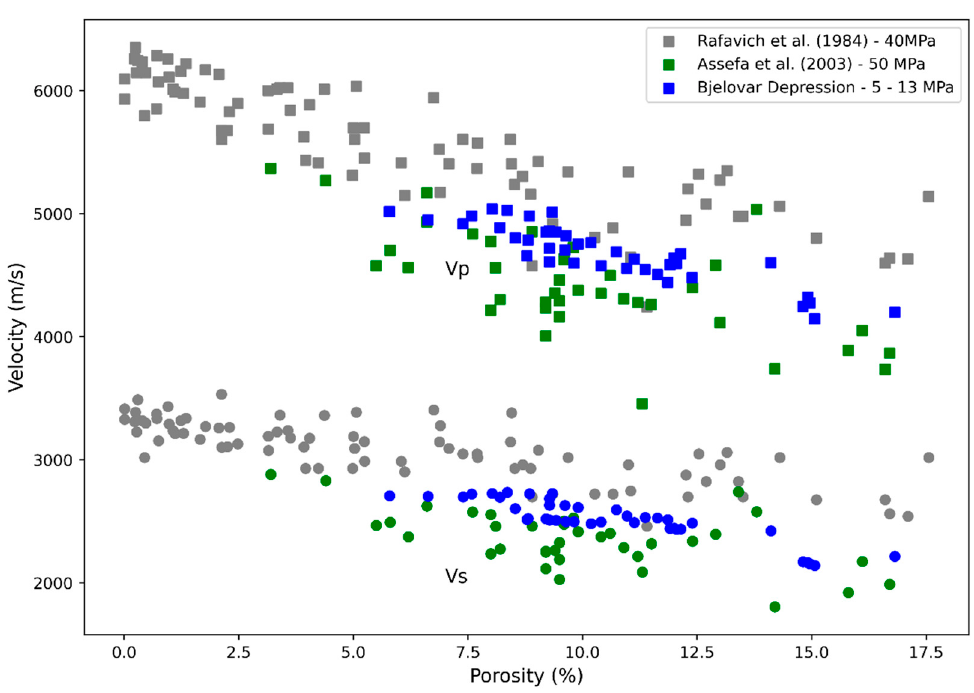
Figure 15. Relationship of velocities and porosity (Rafavich et al. (1984.) [2]—40 MPa, Assefa et al., (2003) [33]—50 MPa, and Bjelovar Depression—5–13 MPa).